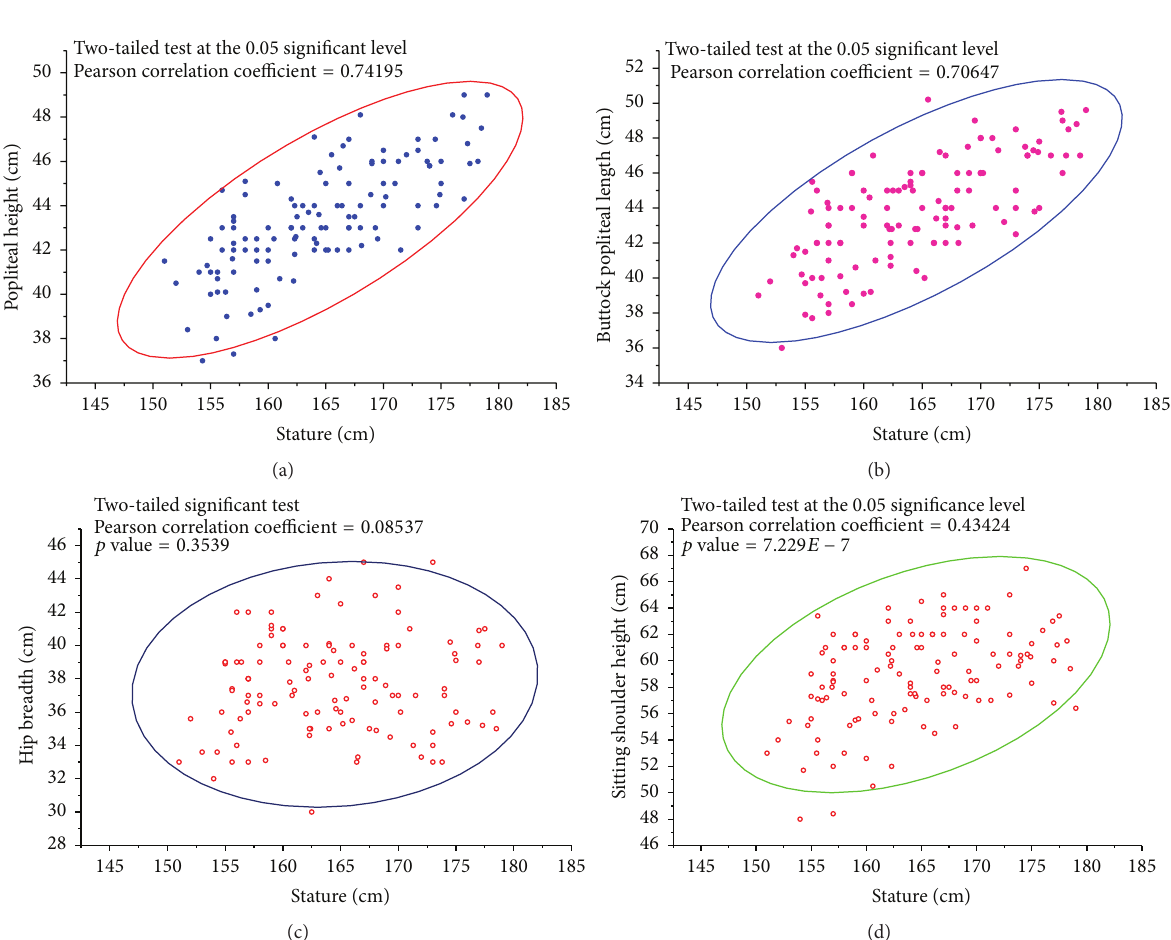
Figure 3: Frequency distribution of the most important anthropometric dimensions related to seat